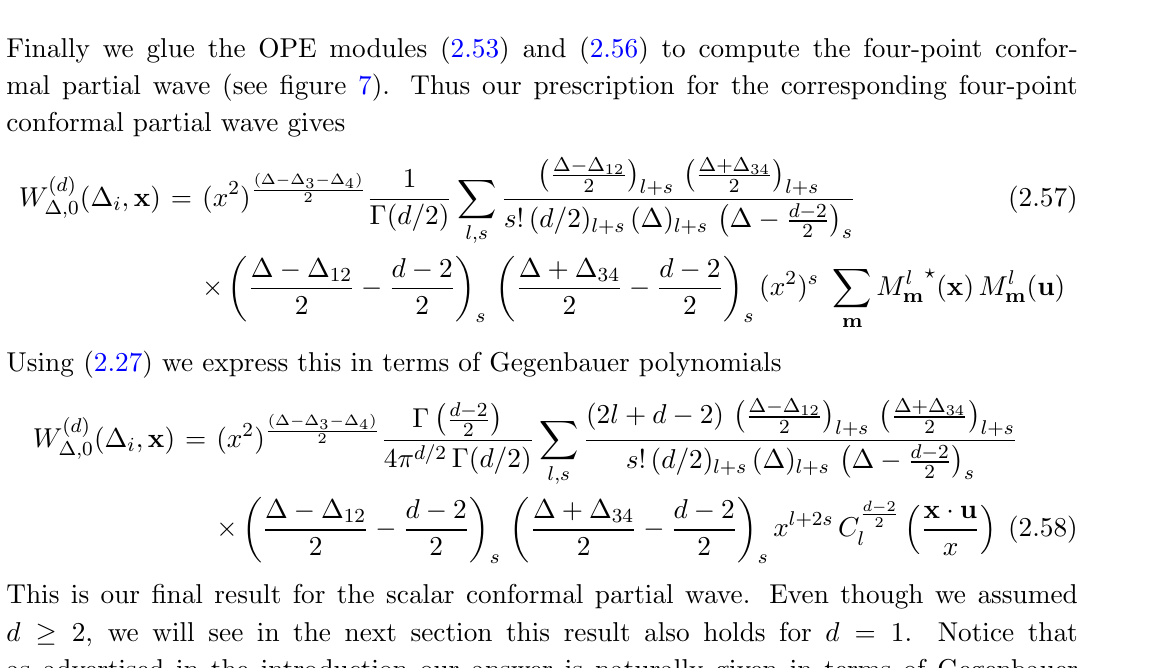
Figure 7 . 4-point block from OPE